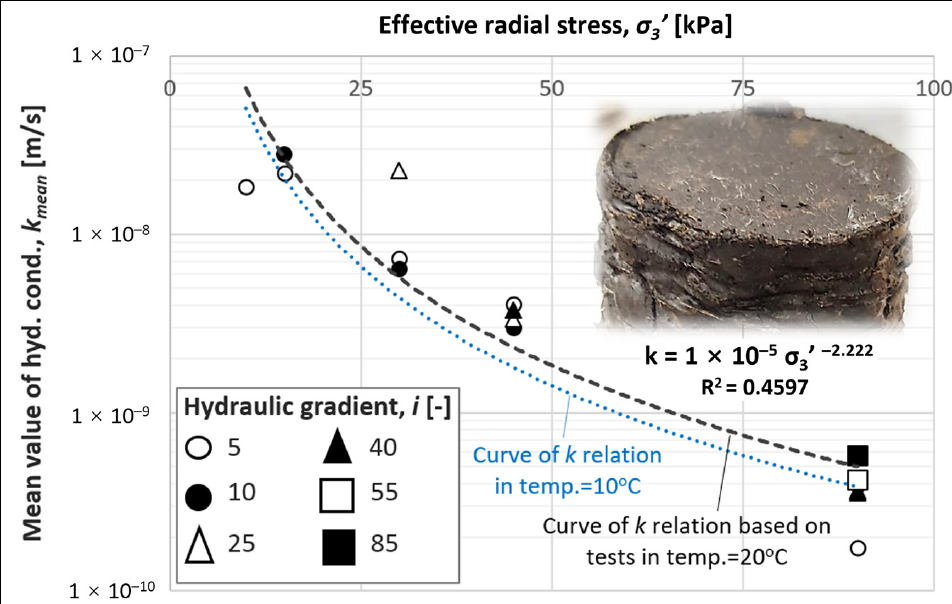
Figure 9. Generalized relationships between the average k value of peat from the analysed Biebrza region as a function of the effective radial stress and hydraulic gradient values derived from triaxial tests. In the background is an exemplary photo of Sample 1 after triaxial permeability tests.